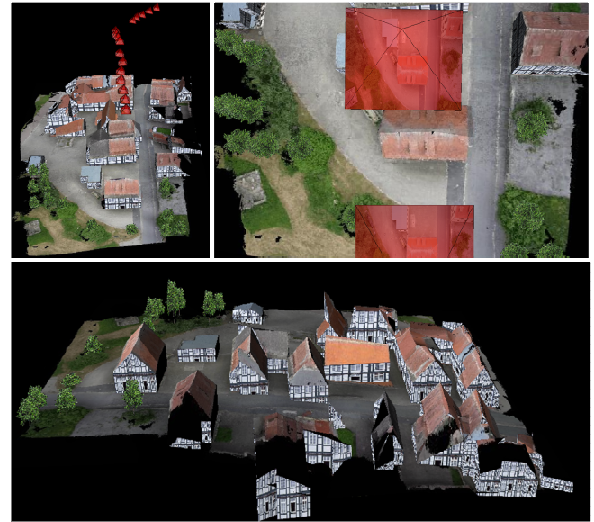
Figure 5: Three views of the textured model. Top left: oblique view. Top right: a nadir view from one of the reference camera perspective. The reference cameras are illustrated by red pyra- mids with corresponding reference images. Bottom: another view of the scene.